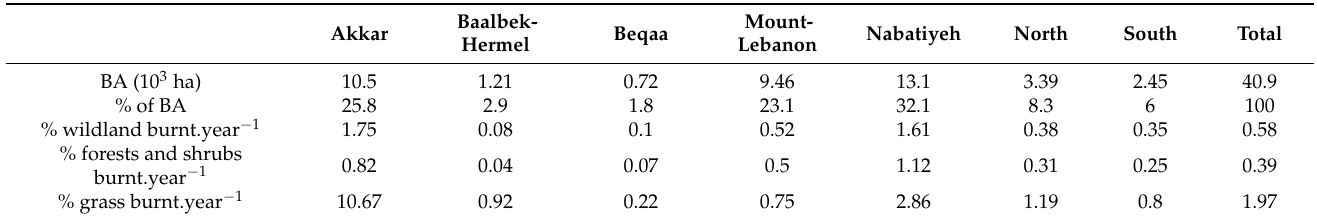
Figure 3. Fire frequency in Lebanon for the period 2001–2020. Table 2. Burnt area (BA 10 3 ha) and percentage of BA per year, per governorate and vegetation type for Lebanon for the period 2001–2020. Akkar